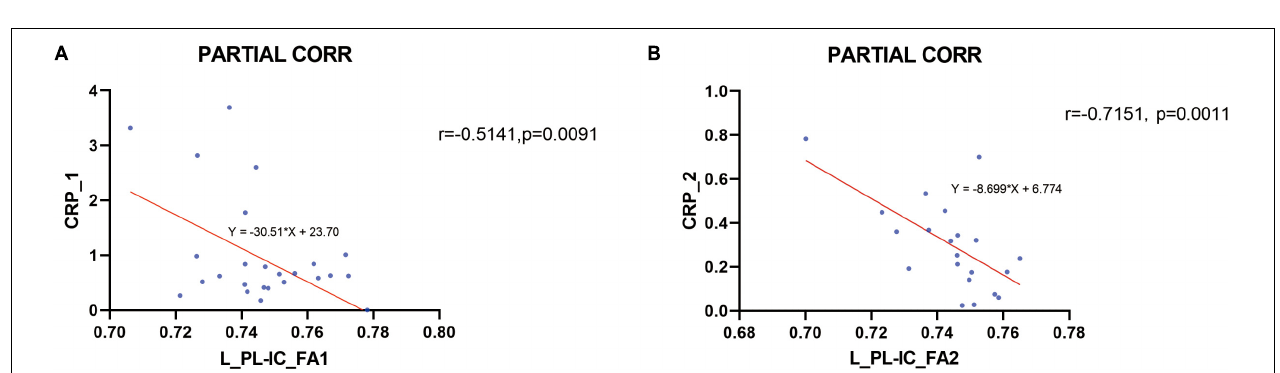
FIGURE 2 | The FA values comparison between post-treatment MDD and HC groups. The decreased FA values of the bilateral superior fronto-occipital fasciculus (SFO) in the post-treatment MDD patients were still significantly lower than that of HC, as indicated in red-green (FWE-corrected p < 0.05, cluster > 20).